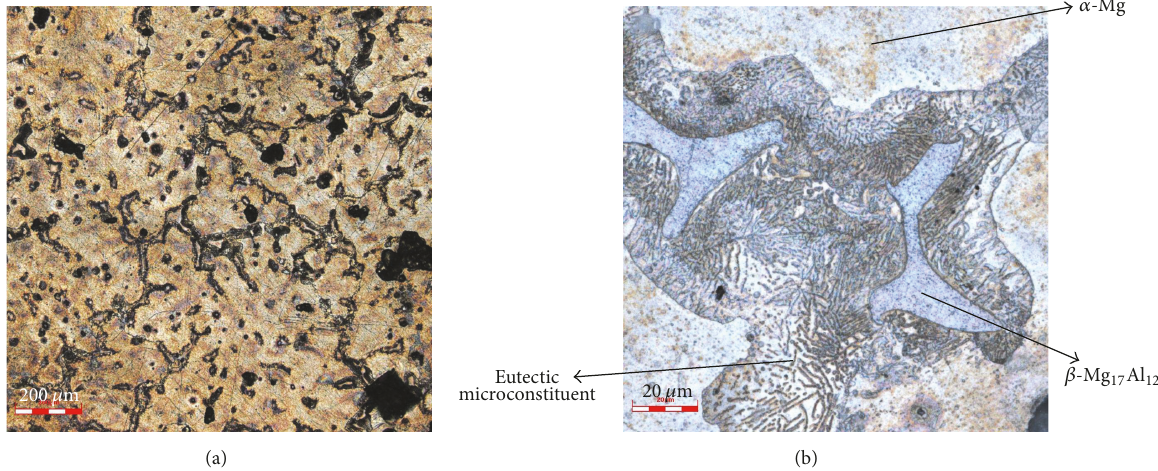
Figure 4: CLSM micrographs of the AZ91D alloy: (a) general view; (b) detailed view.